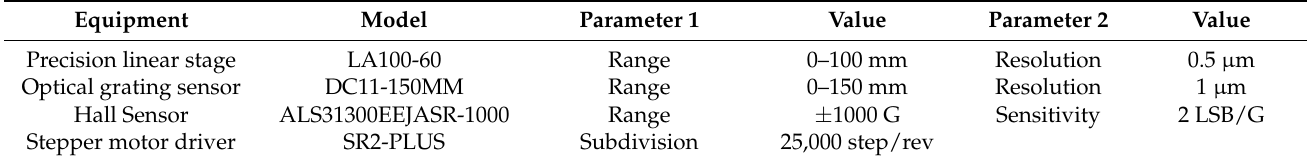
Table 2. Experimental equipment